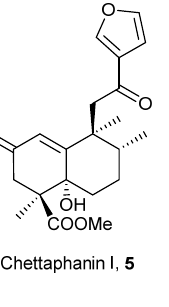
Figure 4. Some important halimanes .